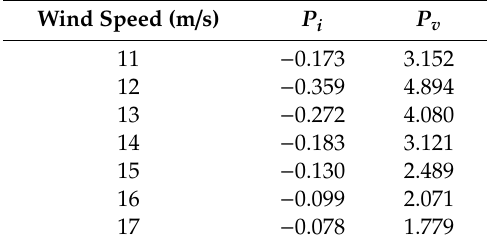
Table 1. Rotor inlet and outlet pressure data for wind speed [16].